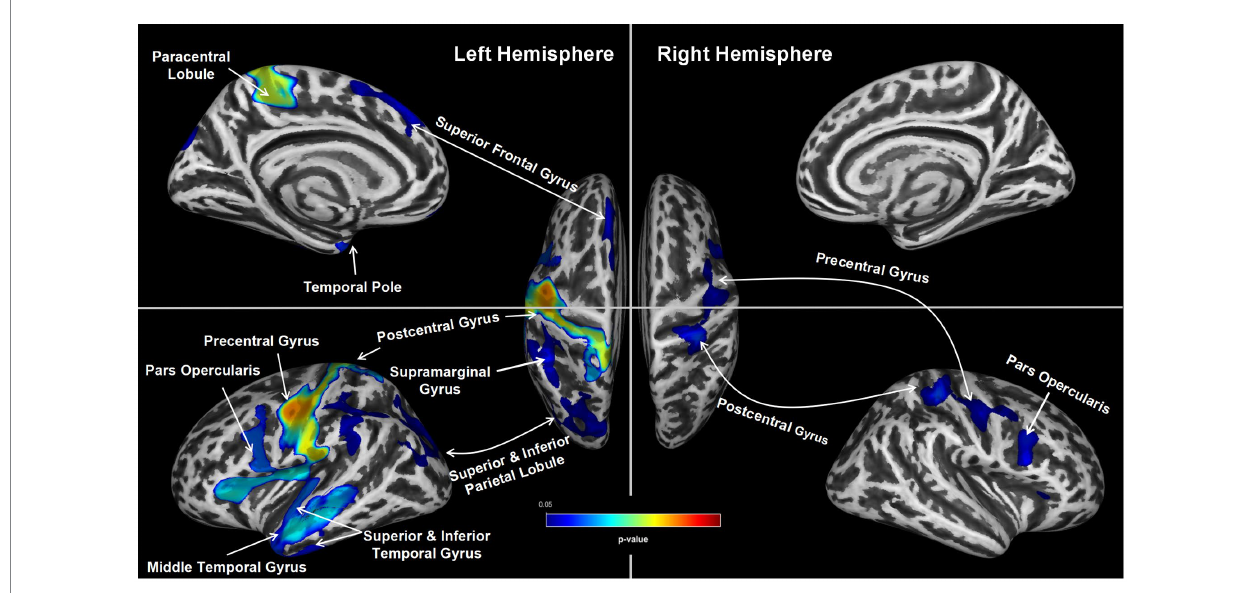
FIGURE 1 Group Differences in Cortical thickness. Group differences in average cortical thickness between the two groups (ESS ≥ 9 vs. ESS < 9). The ESS ≥ 9 group showed significantly thinner bilateral precentral gyrus, postcentral gyrus and caudal middle frontal gyrus, left superior frontal lobe, left superior, middle and inferior temporal lobe, left insula and part of the left superior and inferior parietal lobe (TFCE, pFWE <